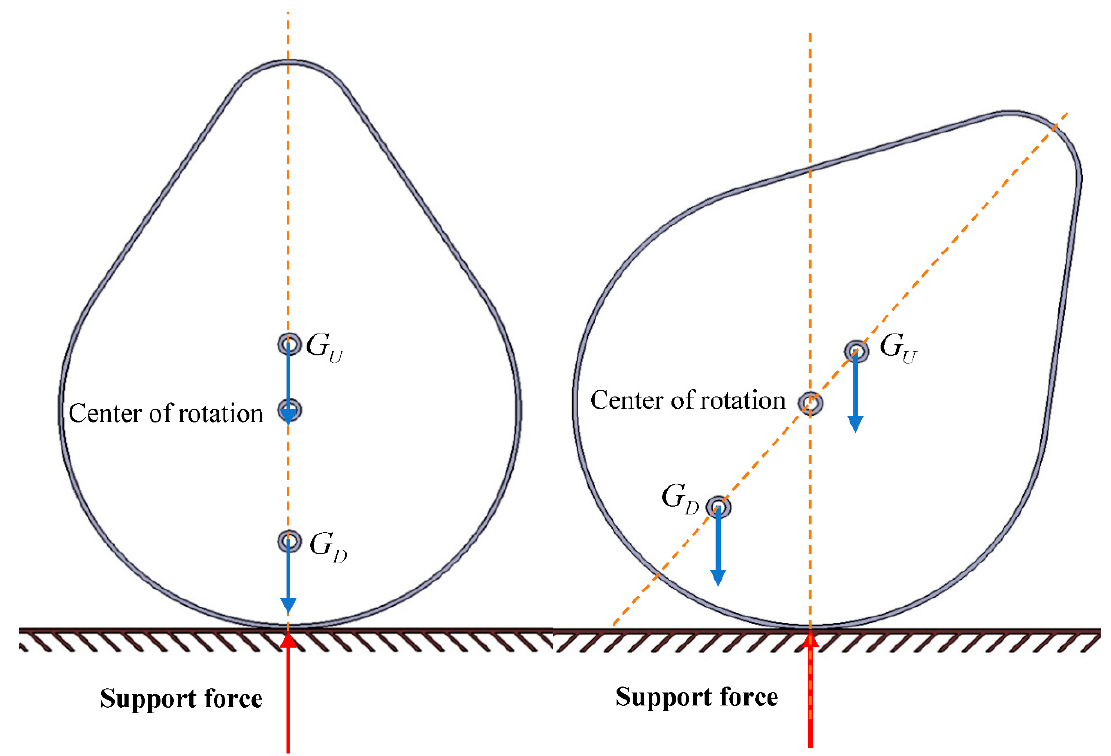
Figure 5. Force analysis diagram of the tumbler in an equilibrium state and toppling state. In practical applications, the robot’s shell is designed to be hollow with a flat bottom. The jumper unit is mounted at the bottom of the shell and can be retracted from the shell while